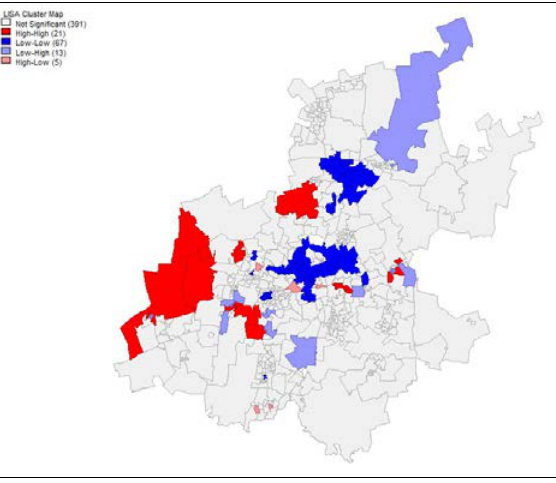
Figure 12. Cluster map of SAMPI in 2001